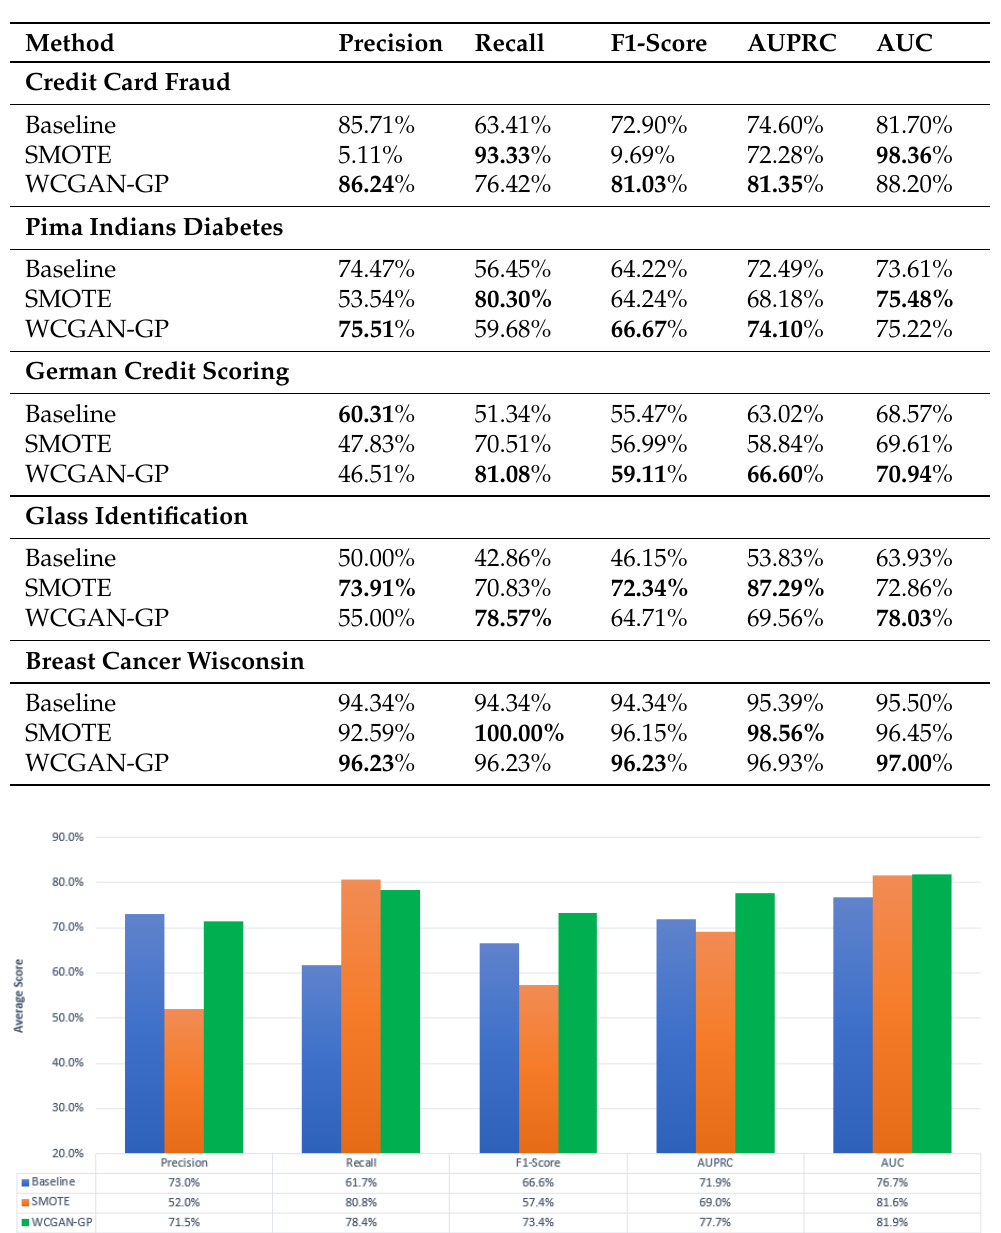
Table 8. Evaluation metrics based on a default threshold of 50%.